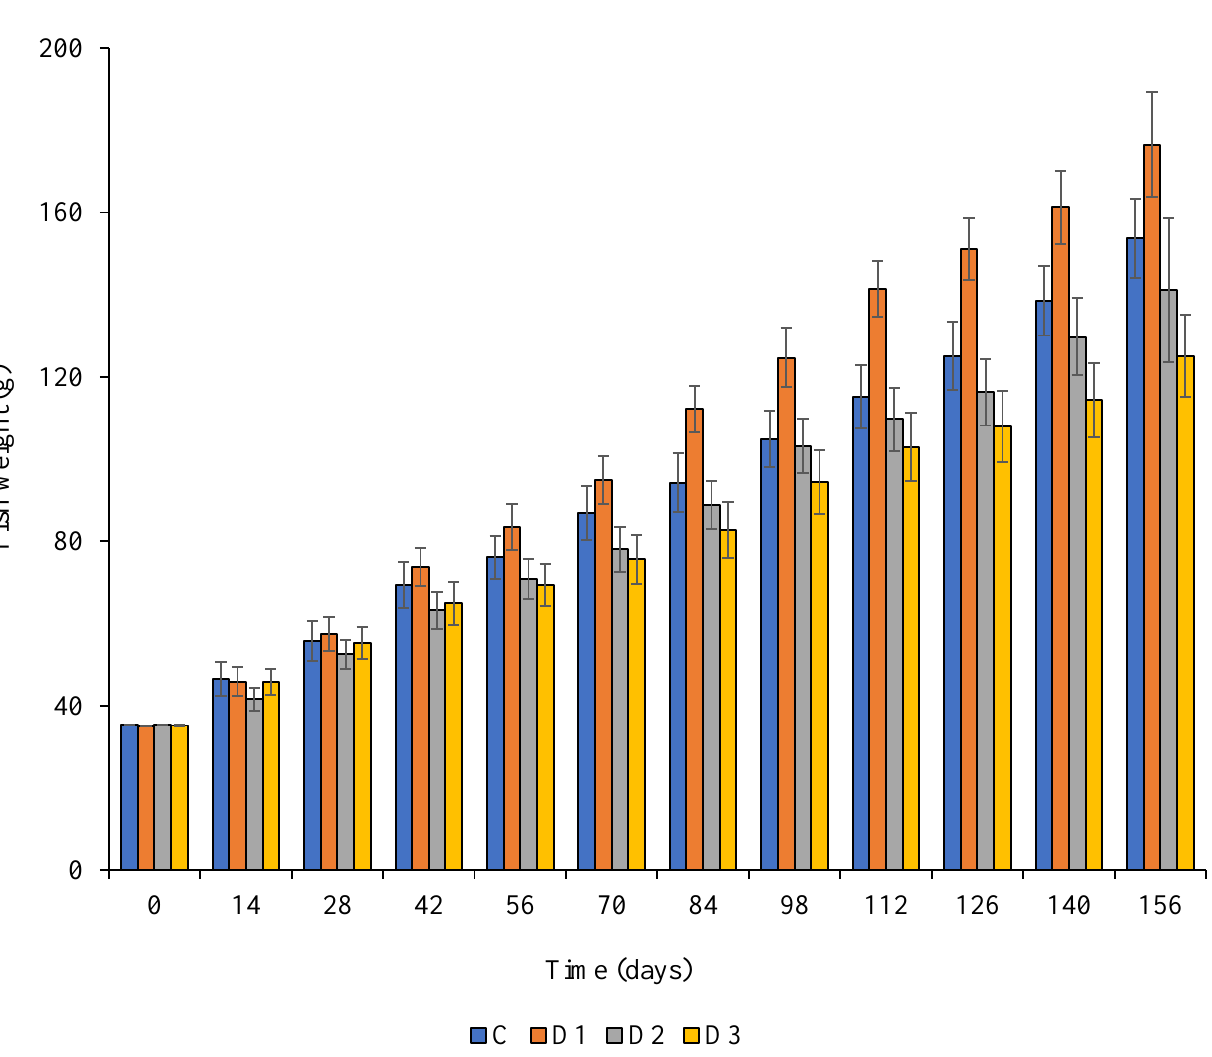
Figure 1. Average weight gain of fish under the four different dietary treatments over a period of 156 days; Control ( C )—(100% FM; 0% BM); BM33 ( D1 )—(67% FM; 33% BM); BM67 ( D2 )—(33% FM; 67% BM) and BM100 ( D3 )—(0% FM; 100% BM) .